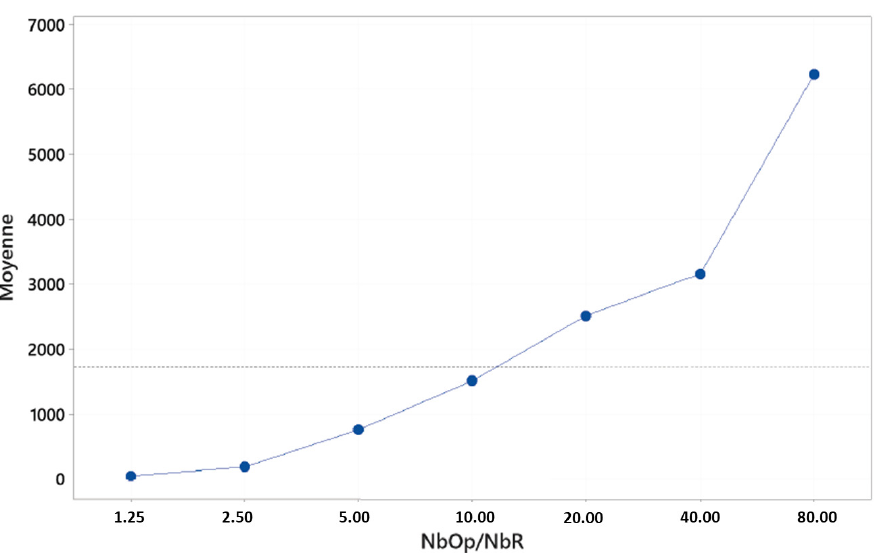
Figure 8. Scalability analysis of the evaluation